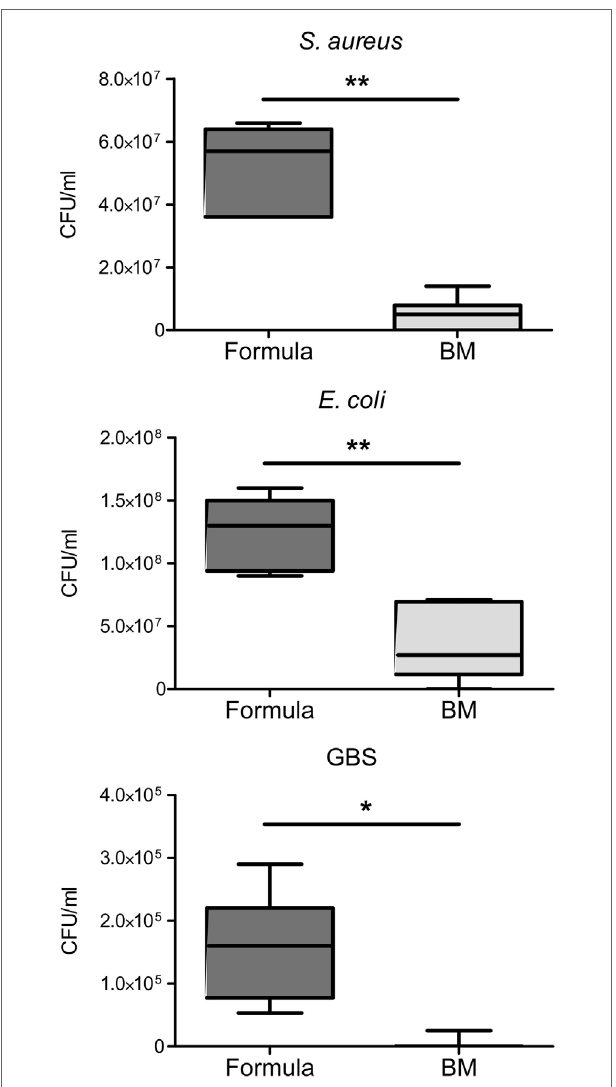
FigUre 4 | Breast milk (BM) inhibits the growth of sepsis-causing pathogens. Staphylococcus aureus , Escherichia coli , and group B streptococci (GBS) were grown over 24 h in infant formula and BM. Box plots show medians (center lines) and interquartile ranges of the concentration of colony-forming units (CFU) ± SEM. * p < 0.005 and ** p < 0.00005, t